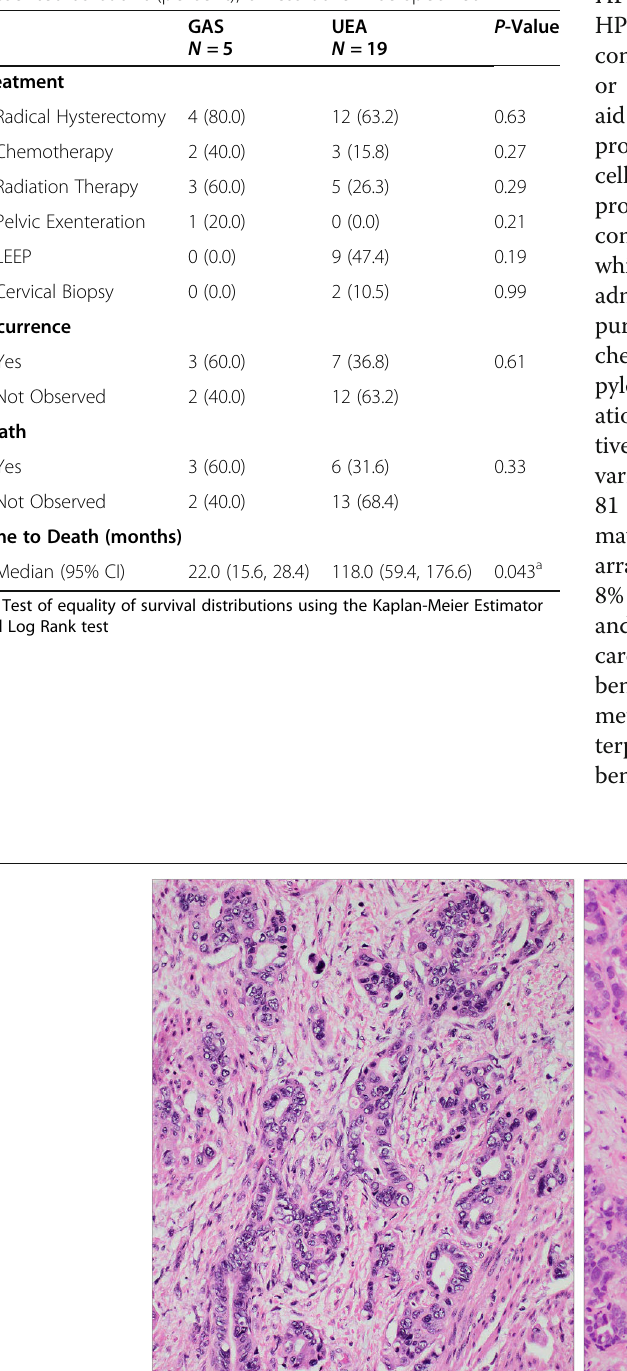
Table 3 Characteristics of treatment and follow up. All data presented as count (percent), unless otherwise specified